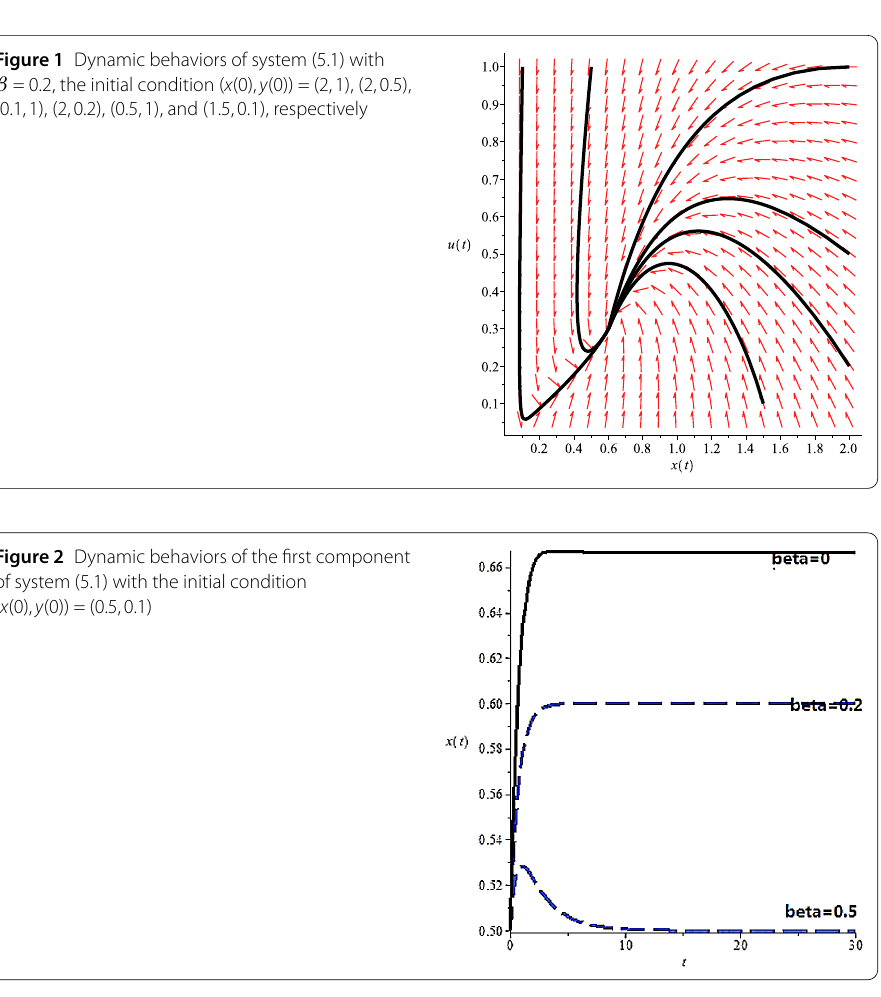
Figure 1 Dynamic behaviors of system (5.1) with β = 0.2, the initial condition ( x (0), y (0)) = (2,1), (2,0.5),